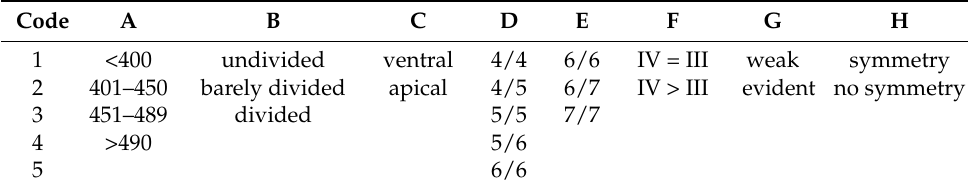
Table 8. Morphological characters considered for the identification of S. delicatus and S. ineffabilis . Every row of a character is represented by a number (1–5) used to link them to the combined morphology phylogenetic tree (Figure 6). A. Length ( µ m); B. Femora; C. Position of the anal pore; D. Aggenital setae; E. Genital setae; F. Length of the 4th segment of pedipalp compared to the 3rd; G. Epirostrum; H. Disposition of the rhagidial organs on tarsi I and